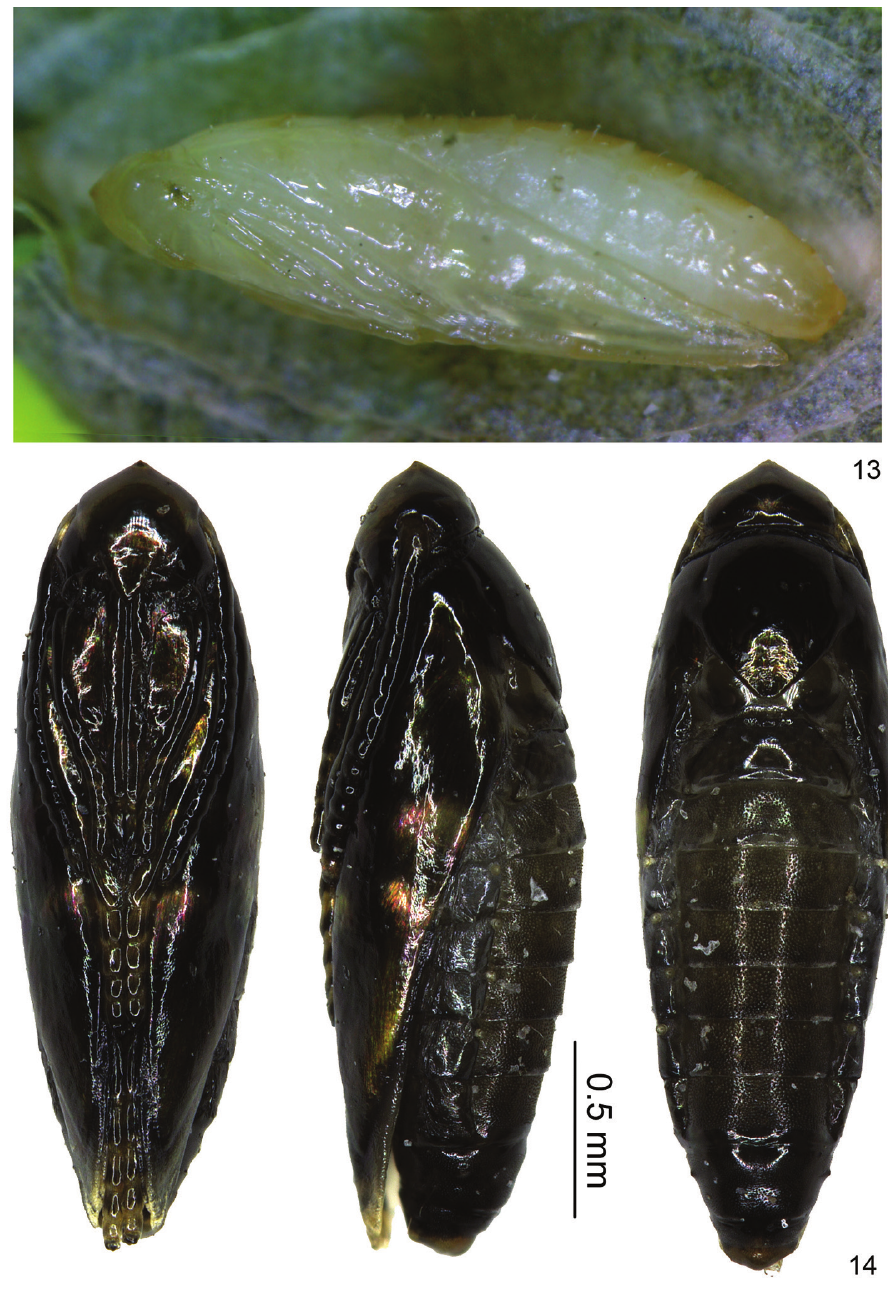
gence in ventral, lateral, and dorsal